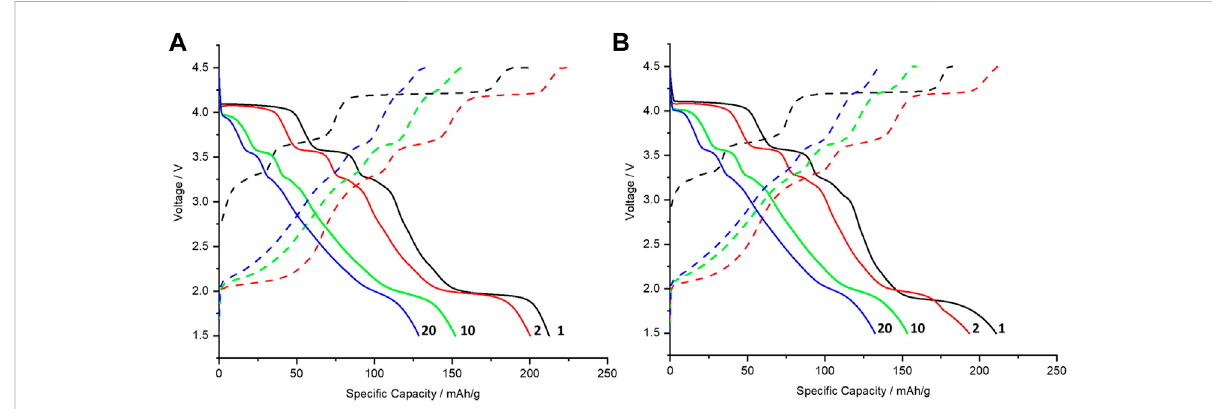
FIGURE 5 Voltage pro fi les of the fi rst, second, tenth, and twentieth galvanostatic charges (dashed lines) and discharges (solid lines) for biotemplated P3- NNM cycled at 0.1 C between 1.5 and 4.5 V, where the working electrode was made using (A) XG and (B) PVDF binders.